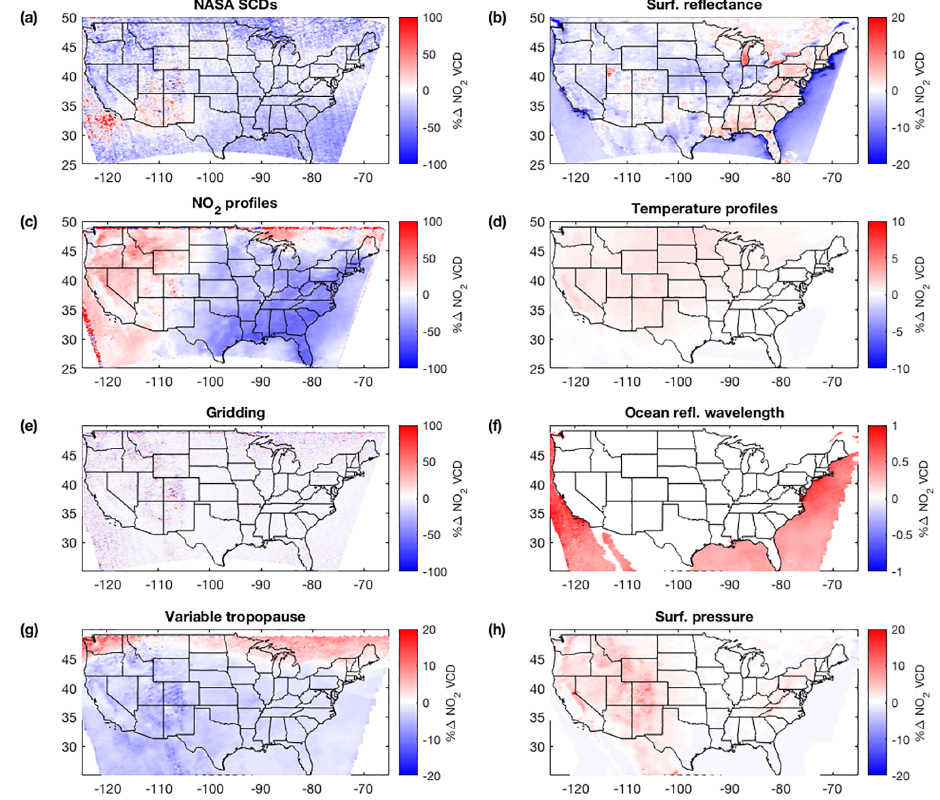
Figure 1. Percent change in the tropospheric NO 2 column due to each of the algorithm improvements. Changes due to (a) new NASA SCDs, (b) new surface reflectance, (c) new monthly NO 2 profiles, (d) new temperature profiles, (e) new gridding method, (f) change in ocean reflectance LUT from 430 to 460nm, (g) switch to WRF-derived tropopause pressure, (h) switch to Zhou et al. (2009) surface pressure methodology. Note that the color scale varies among the plots. Averages are for June–August 2012 and exclude pixels affected by the row anomaly and with cloud fraction > 0 . 2. Monthly average a priori profiles are used for all differences. Wintertime changes and histograms are given in Sect.